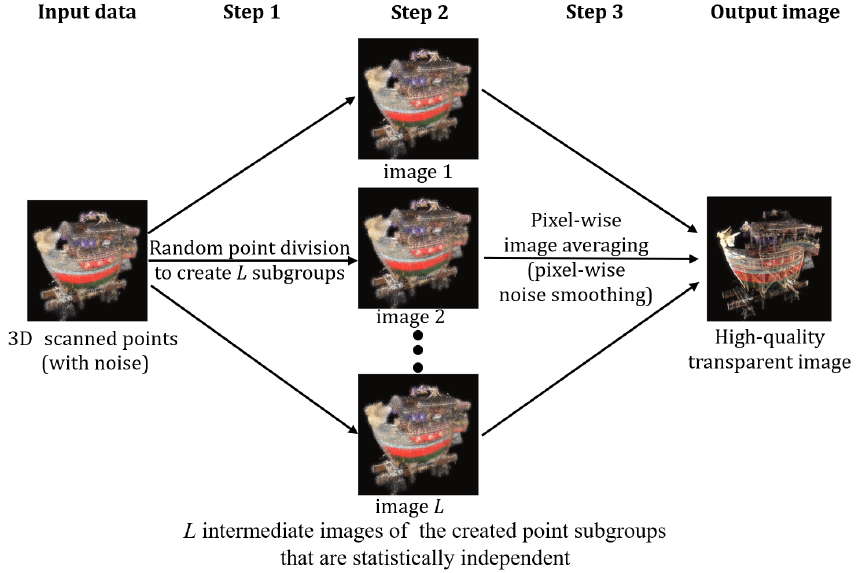
Figure 10. The stochastic point-based rendering (SPBR). The method consists of three steps to create a high-quality transparent image from a group of 3D scanned points: Step (1) random point division, Step (2) intermediate images creation, and Step (3) image